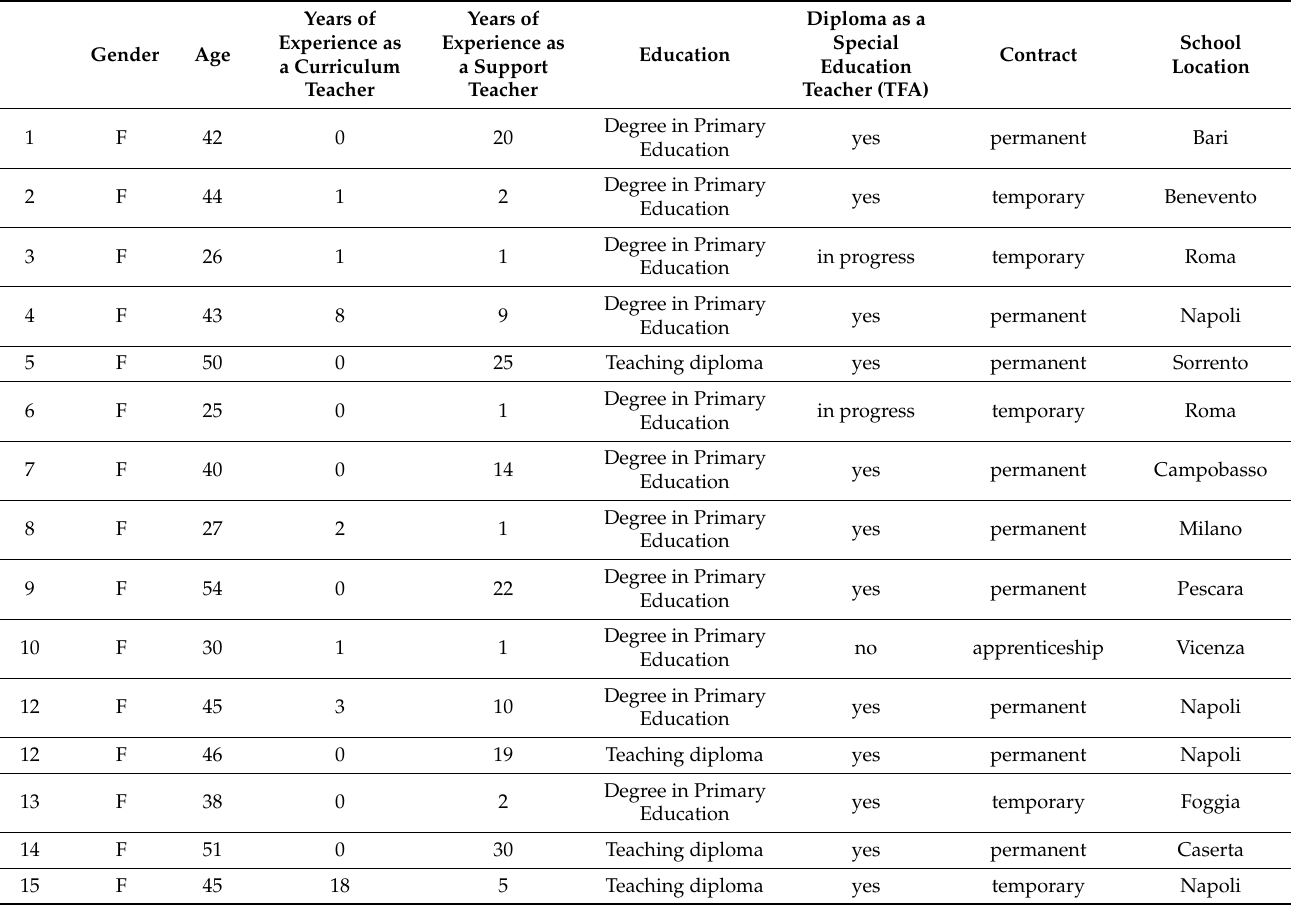
Table 1. Description of teachers’ characteristics ( n =